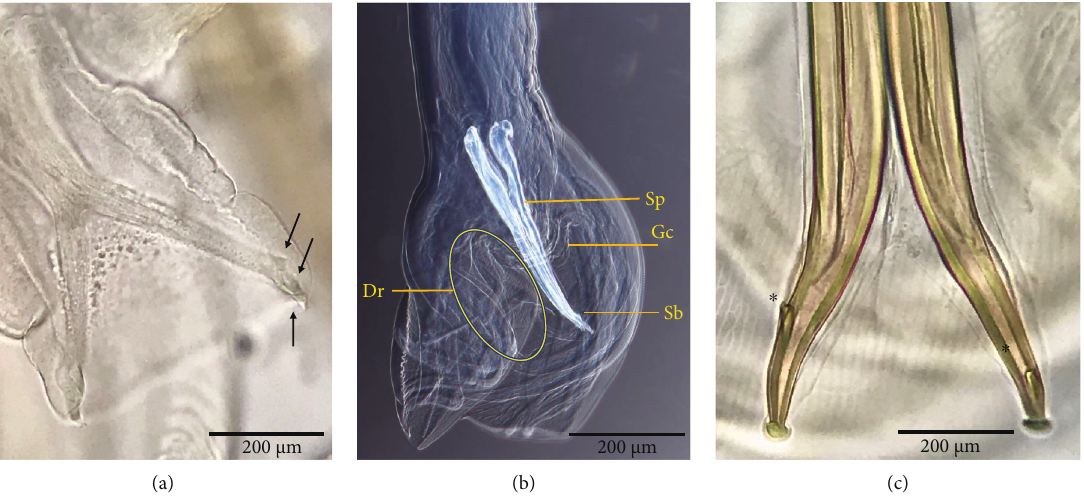
Figure 3: Dorsal ray of H. contortus . (a) Subdivision of branch-nodes parallel to the long-branched lobe to the margin (arrows). (b) Distal end of male dorsal ray (Dr); genital cone (GC) dorsally; spicules (Sp) spicule barbs (Sb). (c) Spicule showing spicule barbs variation at the apex (asterisk; scale bar 200 μ